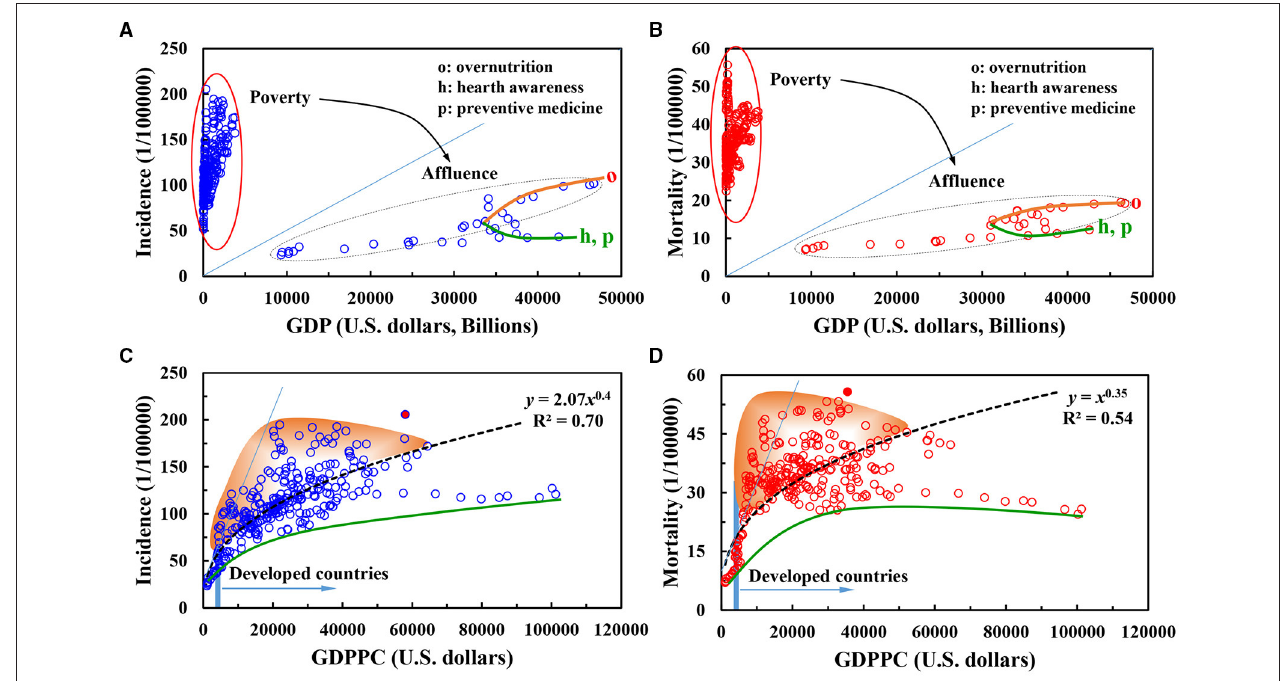
FIGURE 2 | (A–D) Differentiated effects of social public wealth and per capita income level on incidence and mortality rates of female breast cancer.